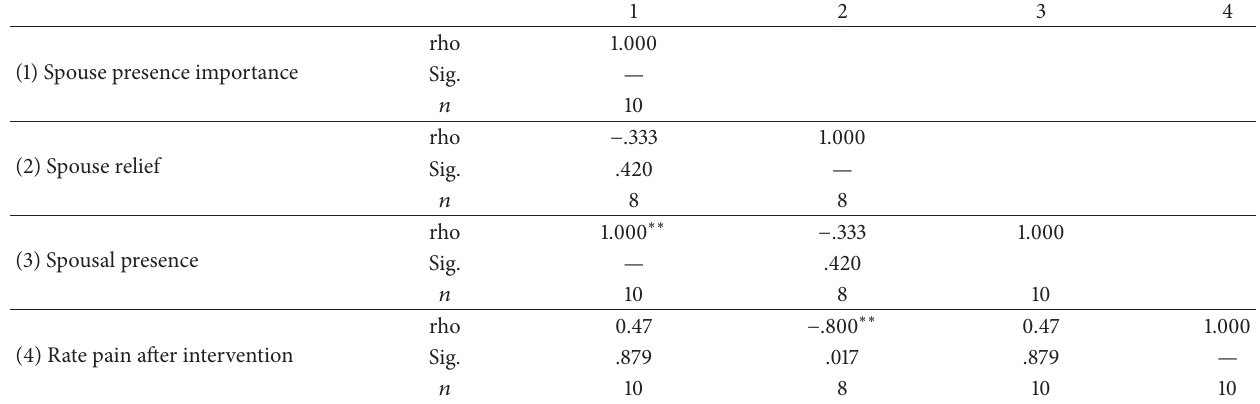
Table 5: Spearman’s rho items correlations of Abuja Instrument for Parturient Pain (AIPP).